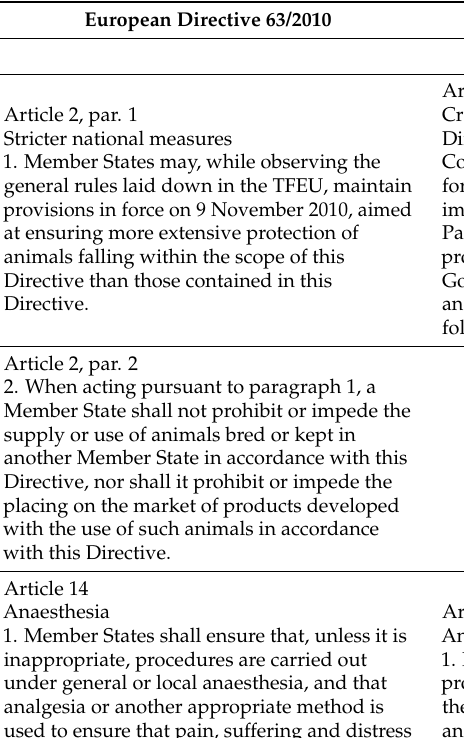
Table 1. European Directive 63/2010 vs. Italian Legislation